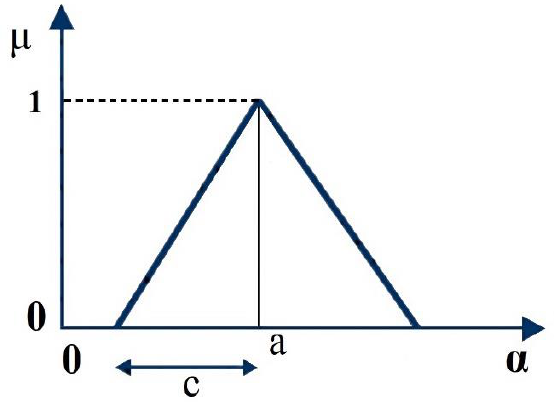
Figure 1. Fuzzy symmetric triangular number.